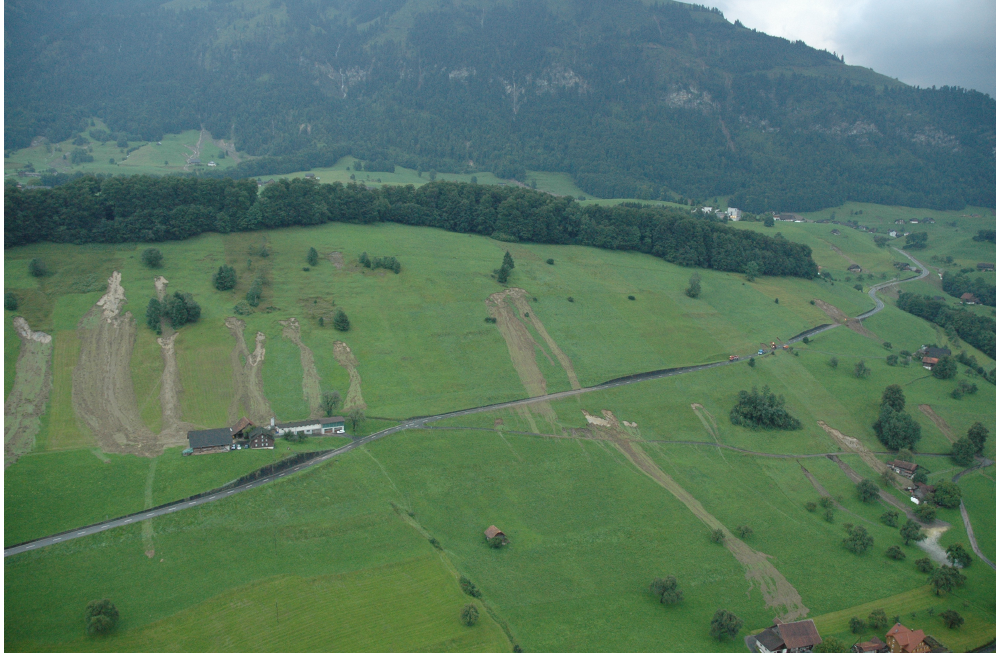
Figure 1. Aerial photo of several hillslope debris flow events in Switzerland following a severe rainfall event in summer 2005. Source: Federal Office for the Environment